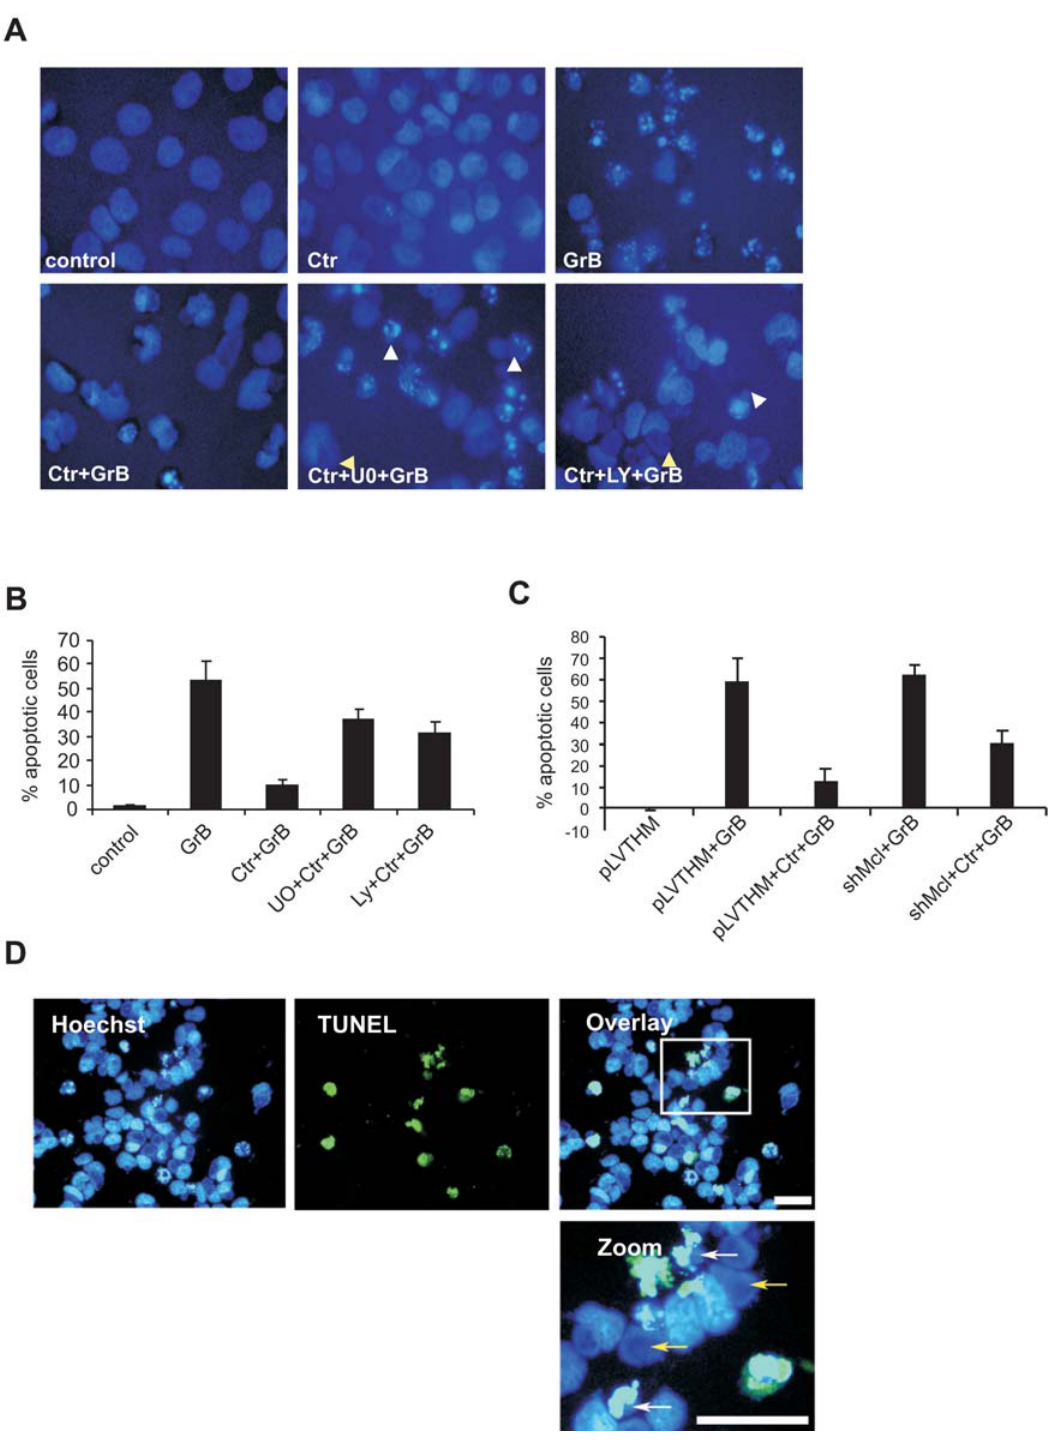
Figure 3. MAPK activation by C.trachomatis is required to resist Granzyme B-mediated cell death. (A) Control and infected cells (Ctr) were treated with MAPK inhibitors U0126 (U0) and LY294002 (Ly) 7 h post infection and at 20 h post infection, the cells were induced to apoptosis with GrB/LV for 4 h. The cells were stained with Hoechst to visualize the apoptotic cells with fragmented chromatin. (B) Quantification of the experiment shown in (A). Apoptotic and non-apoptotic cells were counted from five different fields. The bars represent the mean of three independent experiments 6 SD. (C) Control cells (pLVTHM) or Mcl-1-depleted cells (shMcl-1) were infected (Ctr) and induced to apoptosis by the treatment with Granzyme B (GrB). (D) Sensitization to GrB-mediated cell death is confined only to cells that carry small inclusions. The cells with an inclusion size of 8–10 m M failed to get sensitized for apoptosis despite the inhibition of MAPKs. Yellow arrows point the big inclusions and white arrows point the small inclusions which fail to resist apoptosis. The white bars represent a length of 50 m M.